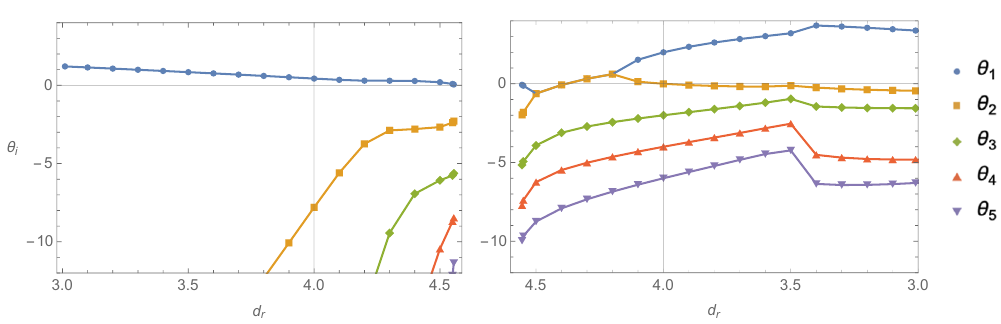
Figure 5 . Scaling exponents θ i , i = 1 , 2 , 3 , 4 , 5 , of the NGFP 1 (left) and NGFP 2 (right, d r axis inverted to highlight continuity through the branching point) as a function of dimension in the large- N k limit for ζ = 1 at order n truncation in the LPA 0 . For the NGFP 1 only the first exponents for d r close to d crit ≈ 4 . 55 are converged; for the NGFP 2 convergence breaks down around d r = 3 . 5 . In between 4 . 1 < d r ≤ 4 . 5 the first two exponents are complex θ is